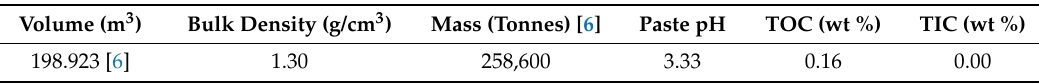
Table 1. Volume, bulk density, paste pH, TOC, and TIC data for the composite mine tailings sample along with the total mass of the tailing piles.